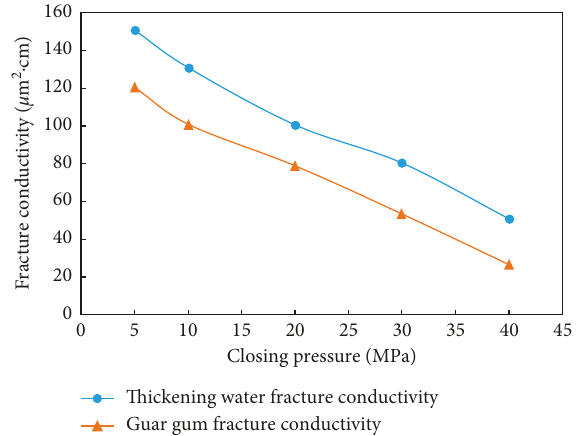
Figure 4: Comparison of fracture conductivity of two kinds of fracturing fluids.